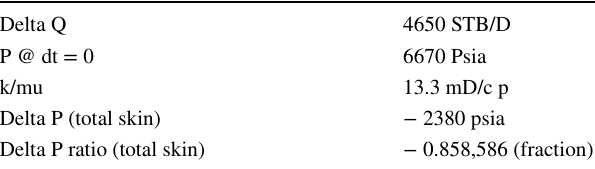
Table 9 Obtained data from buildup pressure test analysis after acidizing operation (derived and secondary parameters)